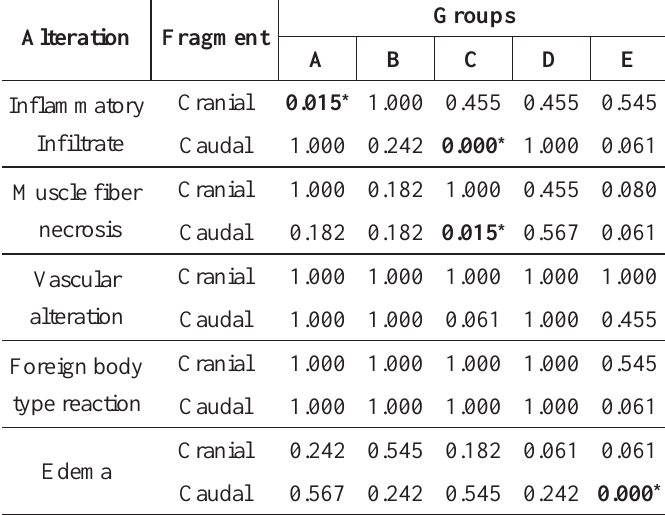
TABLE 1 - p-values for the comparison between the left and right muscles for groups A, B, C, D and E in terms of the percentage with some alteration in the variables